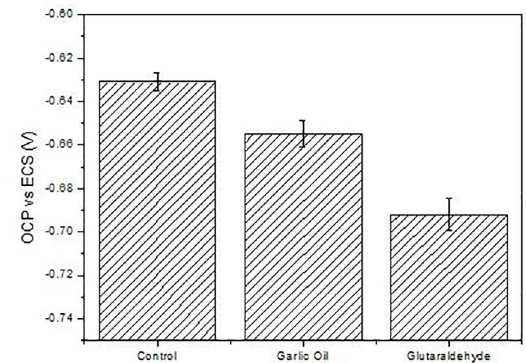
Figure 4. OCP values for the 1020 carbon steel in synthetic seawater. The coupons were previously incubated in SRB-containing culture medium in the absence and presence of the studied biocide